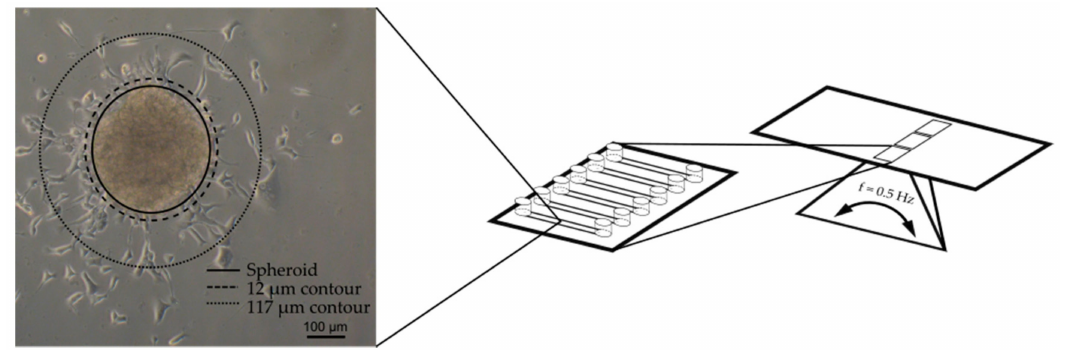
Figure 3. Cardiac spheroids were seeded in fluidic channels on a microscope slide-format and fixed on a rocking platform to drive the perfusion through the device by gravity. The number of nuclei within the area confined by the 12 µ m and 117 µ m contours were counted by high content